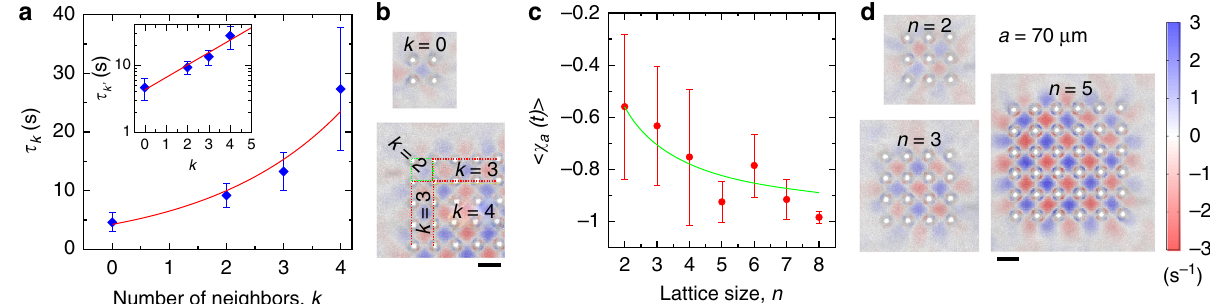
Fig. 4 Persistence time and order parameter dependencies. a Persistence time τ k of a vortex with different number of neighbors k , shown in b . Symbols depict experimental data, solid line is a fi t to theoretical dependence τ k (cid:1) τ 0 exp ð α k Þ , with τ 0 = 4.25 s, α = 0.43, see Eq. (9). Inset: τ k vs k in semi-log scale. Error bars: standard errors of measurements. b Location of bacterial vortices with different number of neighbors k . Scale bar: 70 μ m. Color bar is the same as that in d . c Order parameter 〈 χ a ( t ) 〉 t for a whole vortex lattice (including perimeter) of the size n × n . Lattice constant a = 70 μ m. Symbols shows experimental data, solid line is a fi t 〈 χ a ( t ) 〉 t = − 1 + 0.88/ n . Error bars are calculated from the standard deviations of time series χ a ( t ). d Vorticity map of a bacterial fl ow for lattices of different sizes n × n . Shown examples for n = 2, 3, 5. Lattice constant (distance between pillars) a = 70 μ m, see the Supplementary Fig. 11 for other values of n . Scale bar: 70 μ